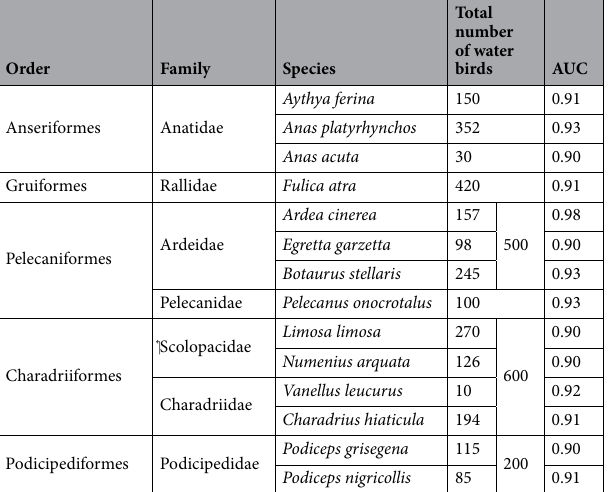
Table 4. The total number and names of water birds listed at 122 observation points and AUC of habitat model for each